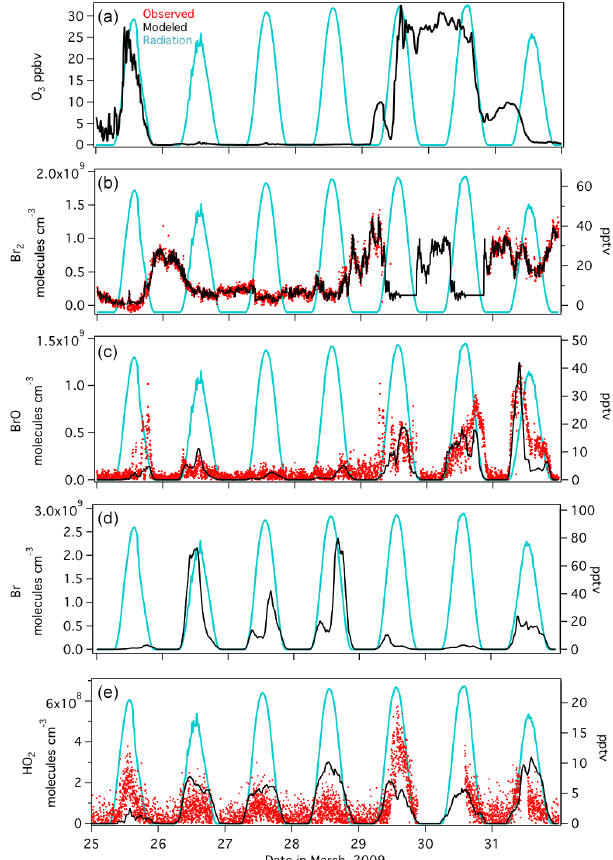
Figure 1. Time series of gas-phase concentrations and mixing ra- tios of O 3 , Br 2 , BrO, Br, and HO 2 in the model (black trace) for the 7-day period simulated. Observations are plotted in red where avail- able for Br 2 , BrO, and HO 2 . O 3 and Br 2 are constrained species in the model. Simulated output of BrO, Br, and HO 2 are smoothed by hourly averaging. Radiation is shown as the cyan trace as a refer- ence. Time is expressed in Alaska standard